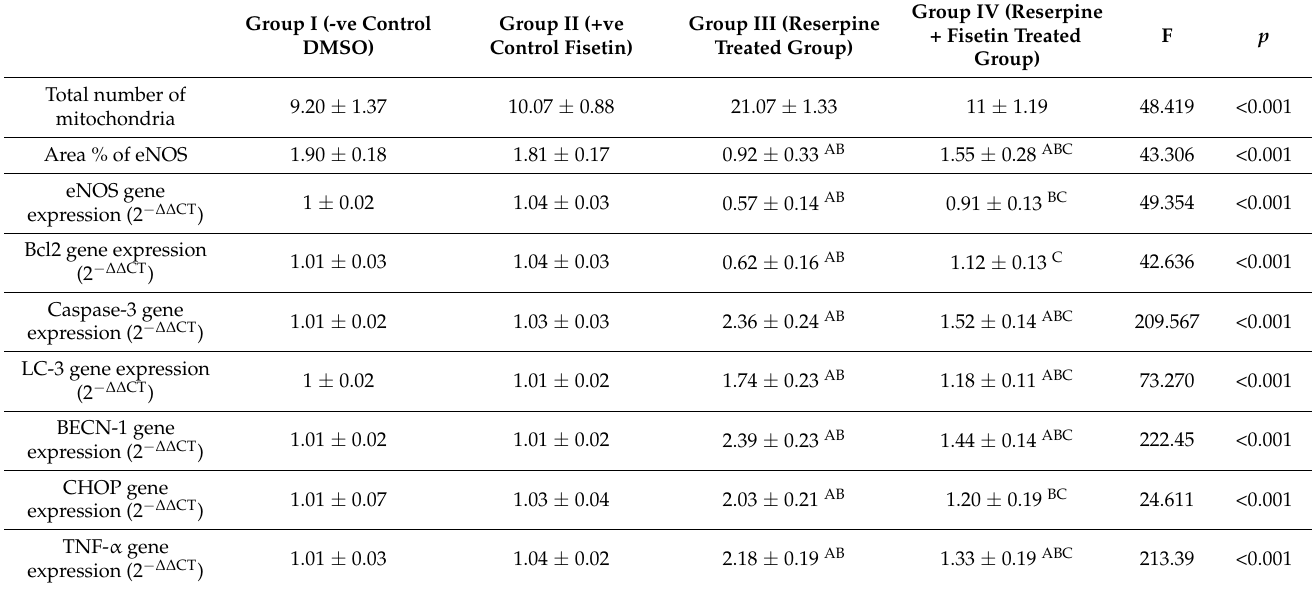
Table 3. Histological and molecular parameters of the cerebral cortex of all studied animal groups. Group I (-ve Control